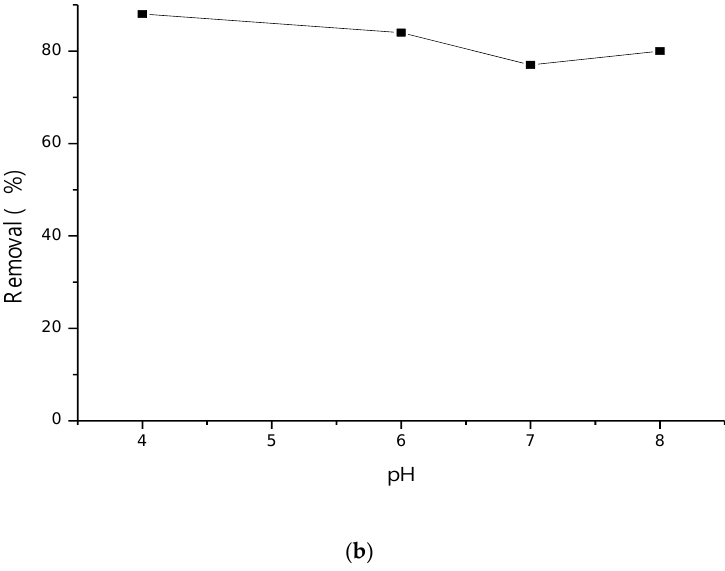
Figure 6. ( a ) ionic strength, ( b ) Effect of pH on methyl violet removal by ß-cyclodextrin polymer, T= 30°C.